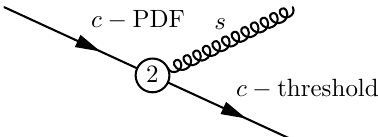
Figure 3 . Insertion of the power-suppressed Lagrangian